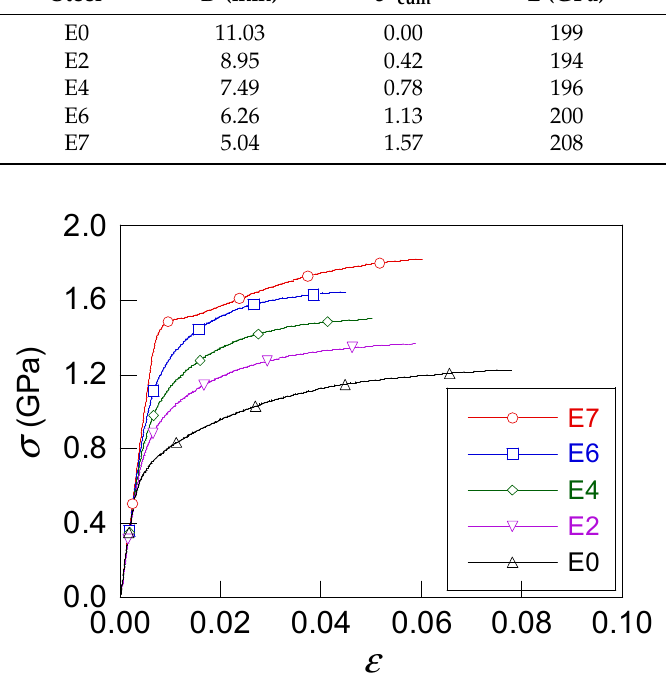
Figure 1. True stress vs. true deformation ( σ − ε ) of steels from family E.